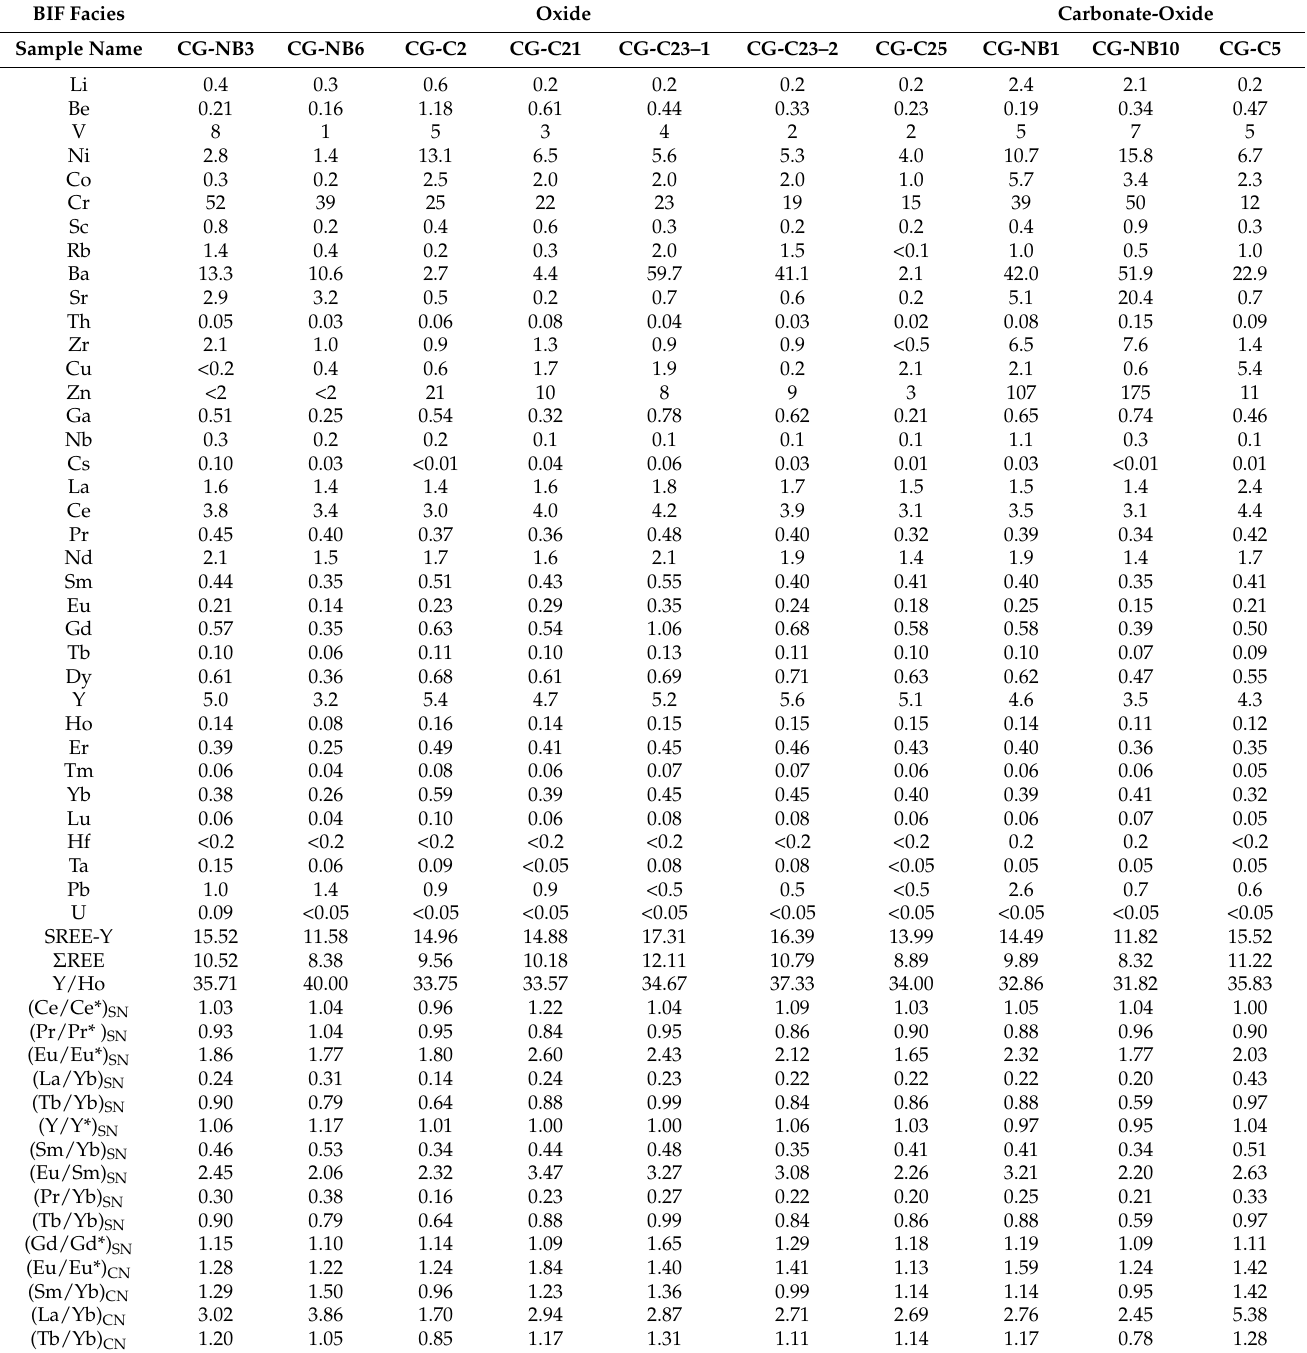
Table 5. Trace element compositions (in ppm) and ratios of the Nabeba